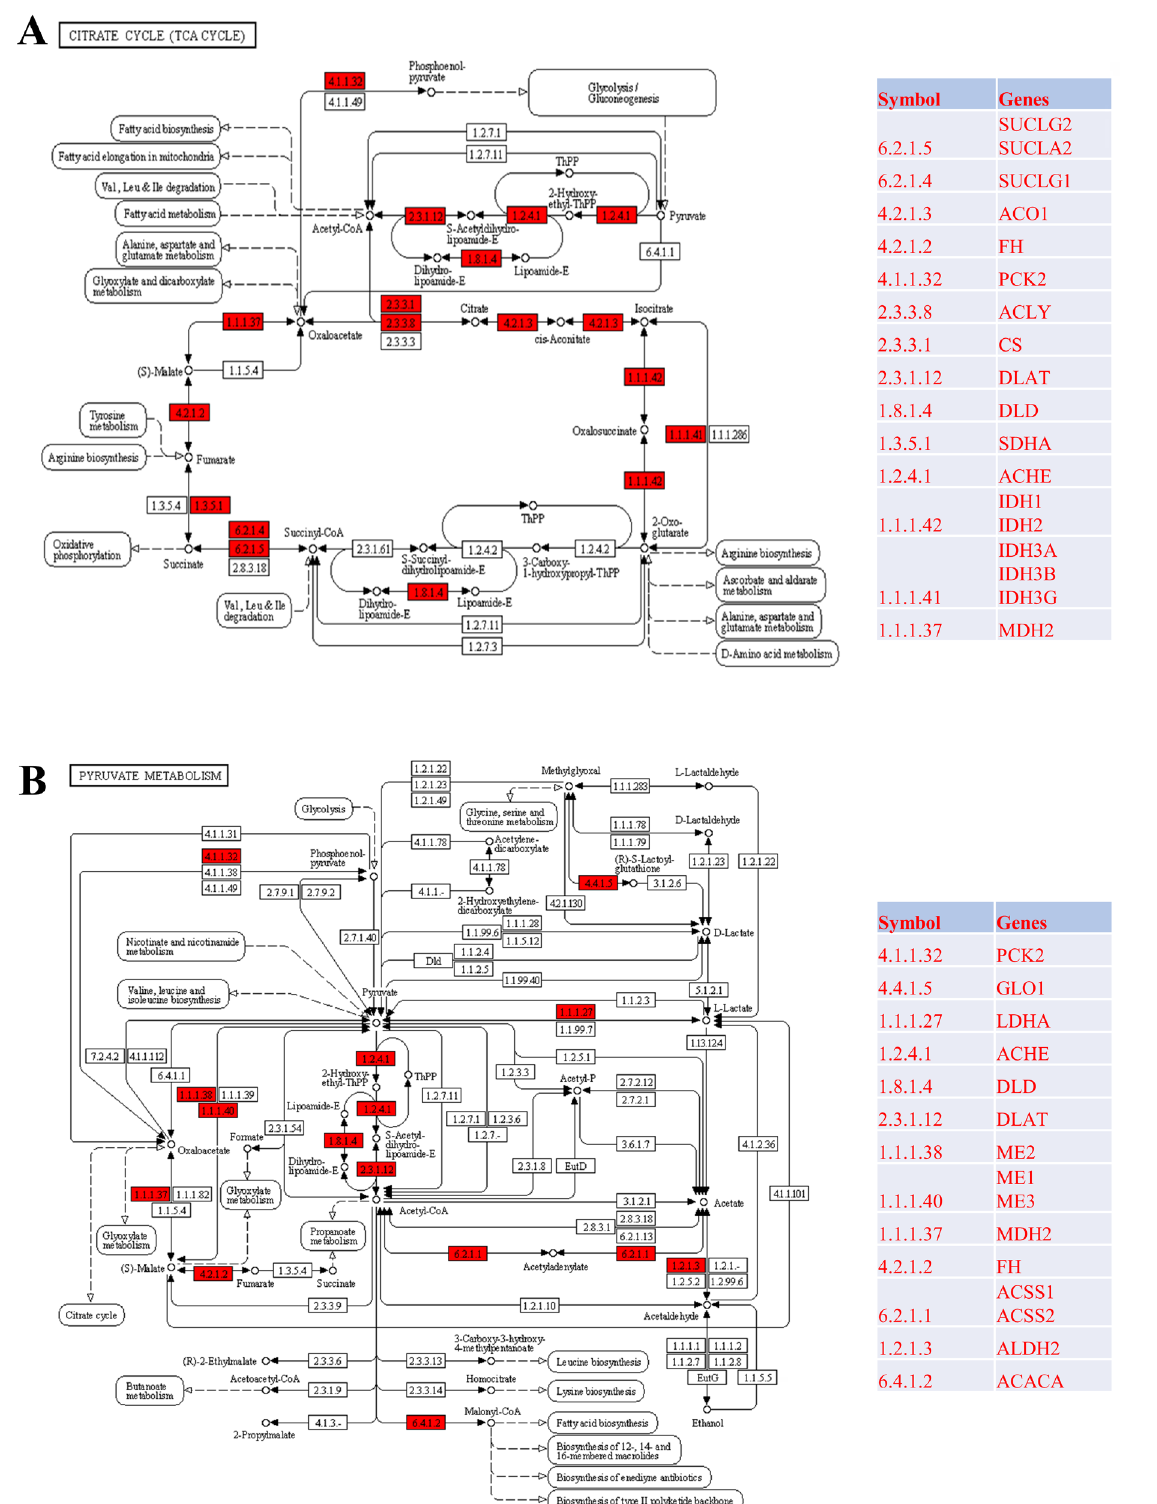
Figure 3. Location of differentially expressed genes in TCA cycle (A) and pyruvate metabolism (B). The red boxes represent the